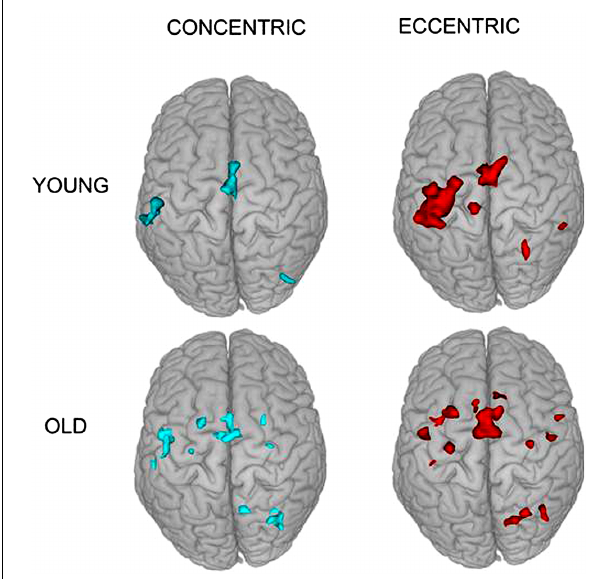
FIGURE 2 | Superior view of group activation during the two types of contractions in the two groups. It is clear that brain activation in young individuals are more localized in the contralateral (left) hemisphere but that in older adults are more distributed in the two hemispheres.